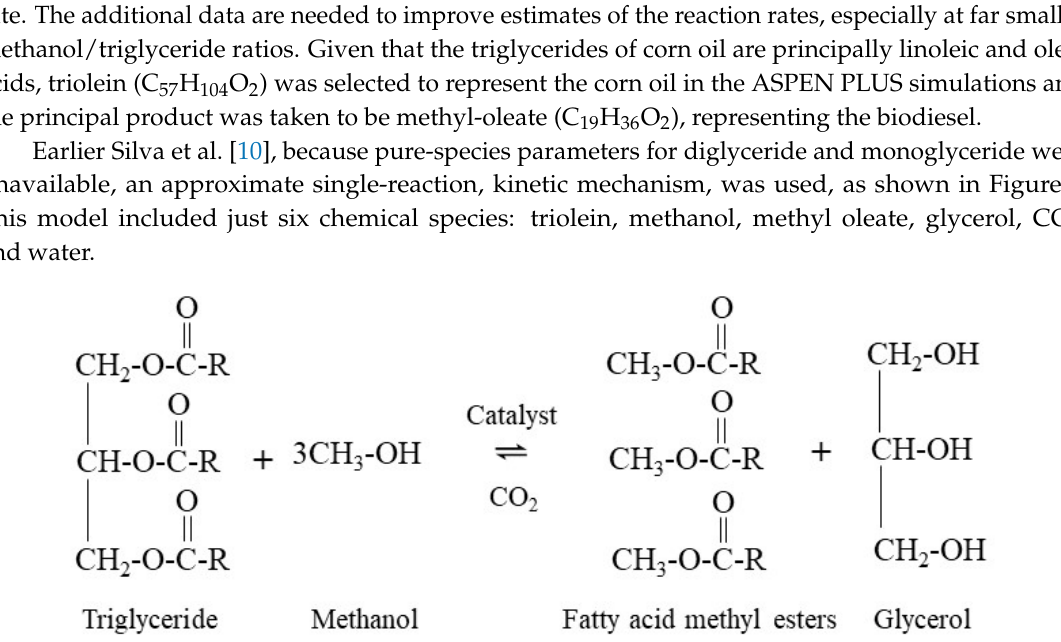
Figure 1. A single reversible transesterification reaction to convert triglycerides (TG) into biodiesel.